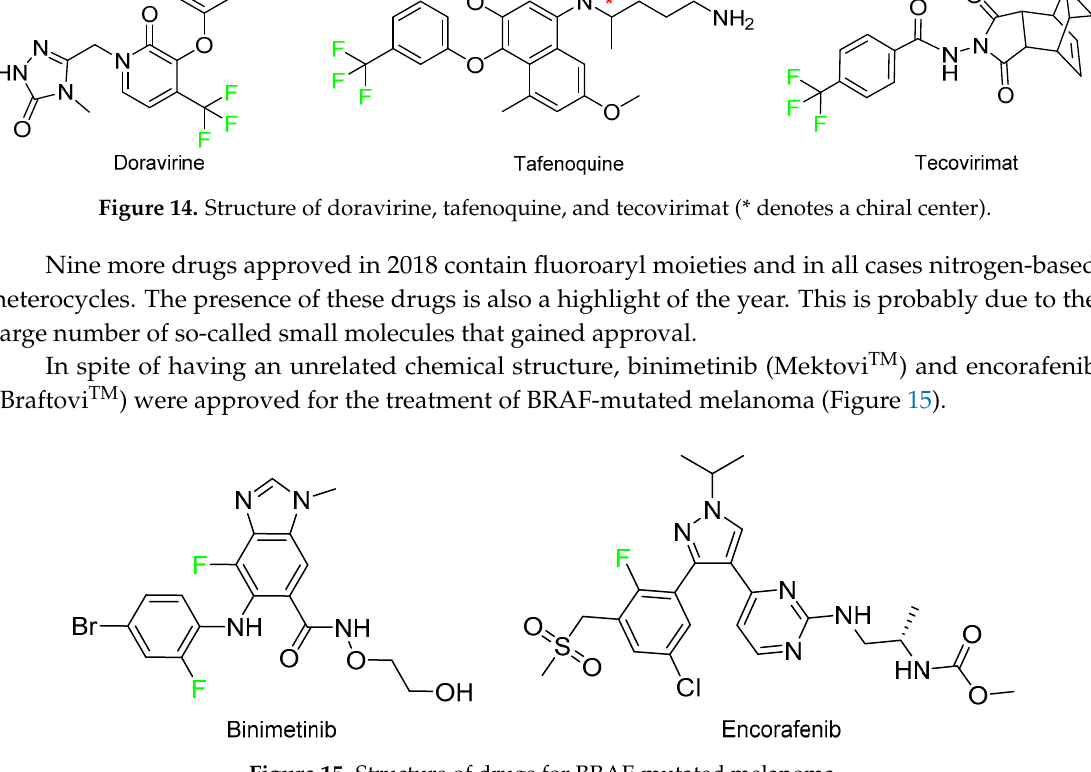
Figure 13. Structure of elagolix sodium.